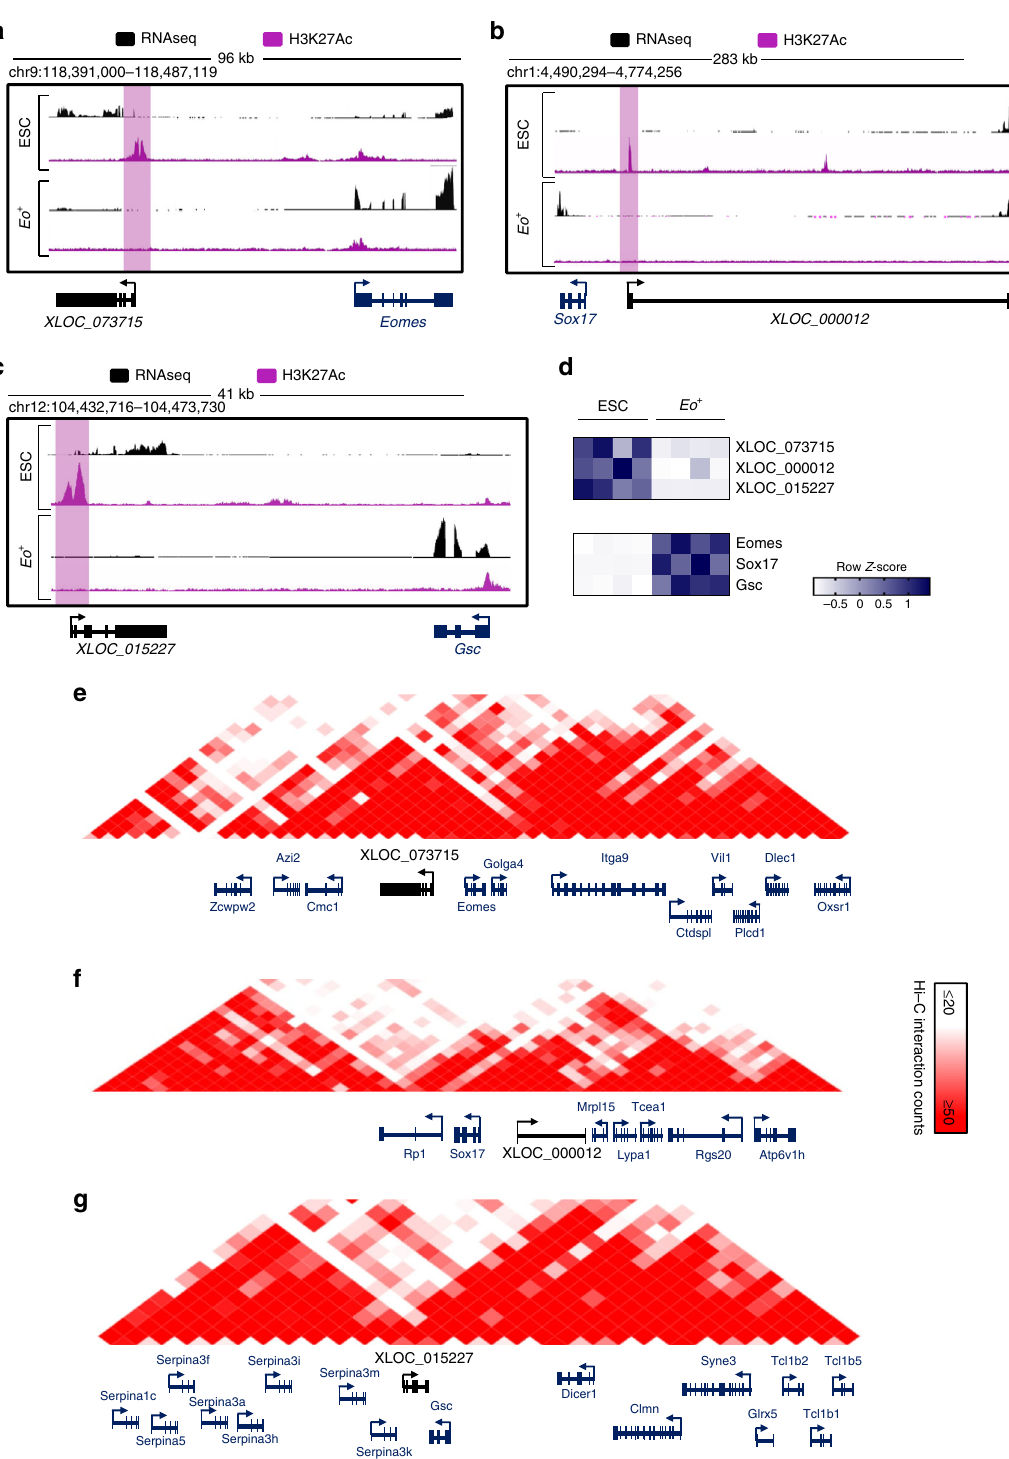
Fig. 5 Pluripotency speci fi c enhancer associated lncRNA loci interact with mesendodermal transcription factors. a RNAseq and H3K27Ac reads in ESCs and Eo + for Eomes and the lncRNA XLOC_073515 . b RNAseq and H3K27Ac reads in ESCs and Eo + for Sox17 and the lncRNA XLOC_000012 . c RNAseq and H3K27Ac reads in ESCs and Eo + for Gsc and the lncRNA XLOC_015227 . d Heatmap showing expression of three lncRNAs candidates ( XLOC_073515 , XLOC_000012 , and XLOC_015227 ) and their cognate PCGs ( Eomes , Sox17, and Gsc ) in ESCs and Eo + . e Hi – C interaction density heatmap of a genomic region where Eomes and lncRNA XLOC_073715 are centered. f Hi – C interaction density heatmap of a genomic region where Sox17 and lncRNA XLOC_000012 are centered. g Hi – C interaction density heatmap of a genomic region where Gsc and lncRNA XLOC_015227 are